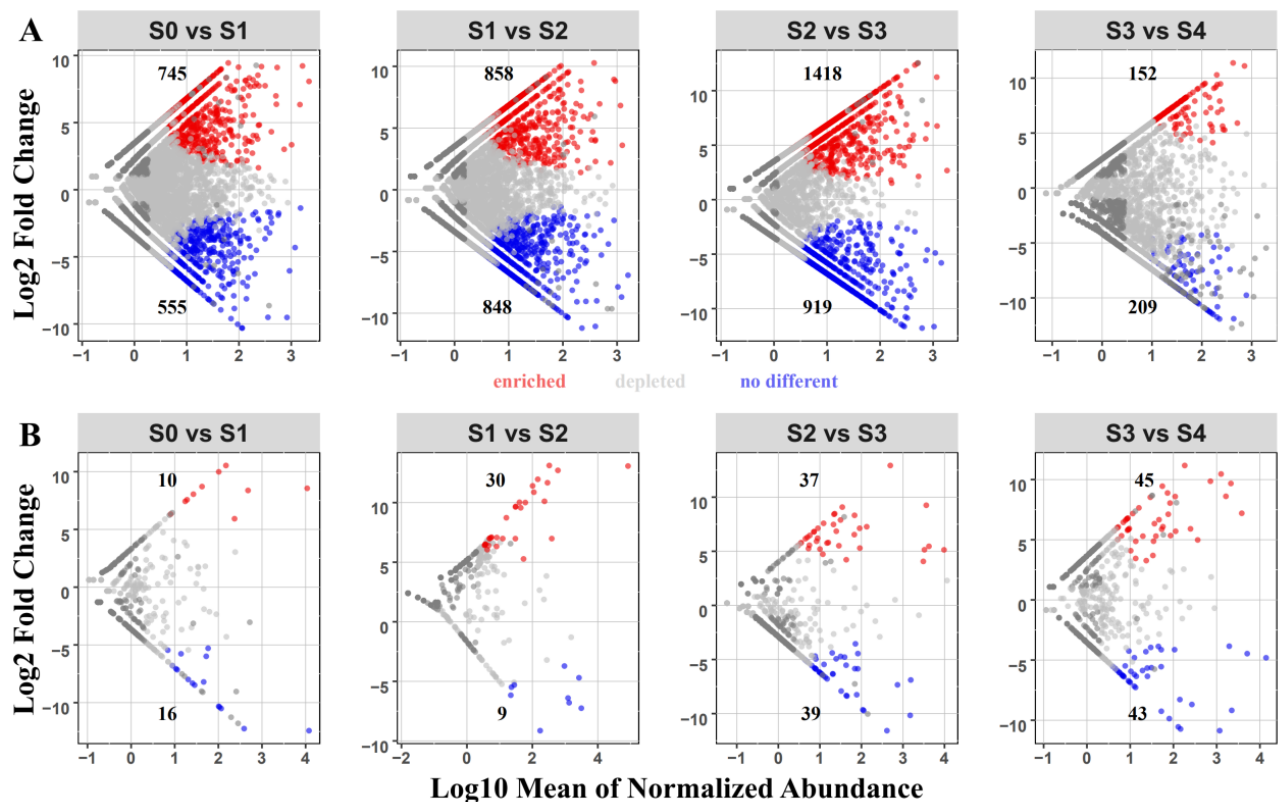
Figure 4. Volcano plots illustrating bacterial ( A ) and fungal ( B ) OTUs in poplar wood with increases (red) and reductions (blue) in abundance between successional stages; Each point indicates an individual OTU.